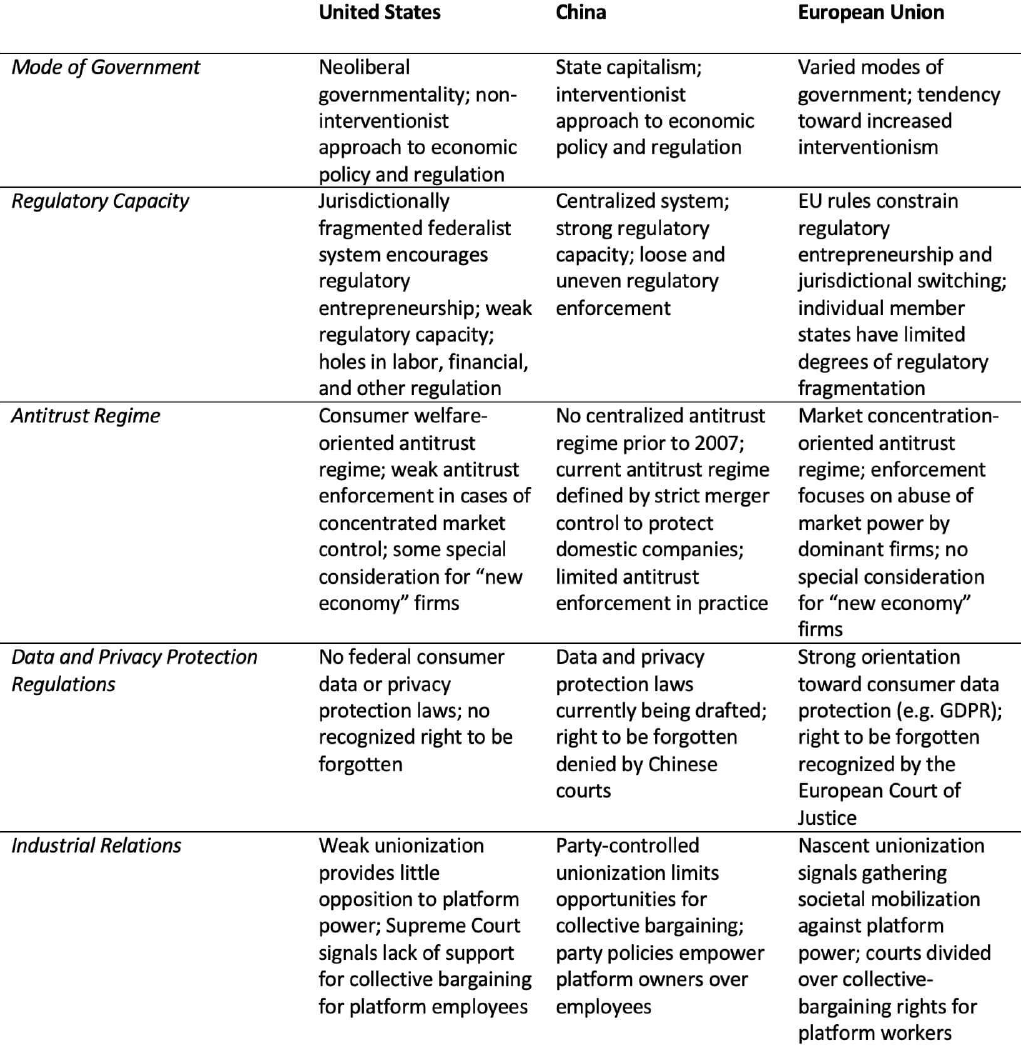
Table 1: Spaces of Platform Capitalism I: Regulatory Geographies Table 2 takes this schema as a point of departure: Uber is offered as an example of a labor platform; Airbnb and Amazon stand in as proxies for capital and commodity platforms,